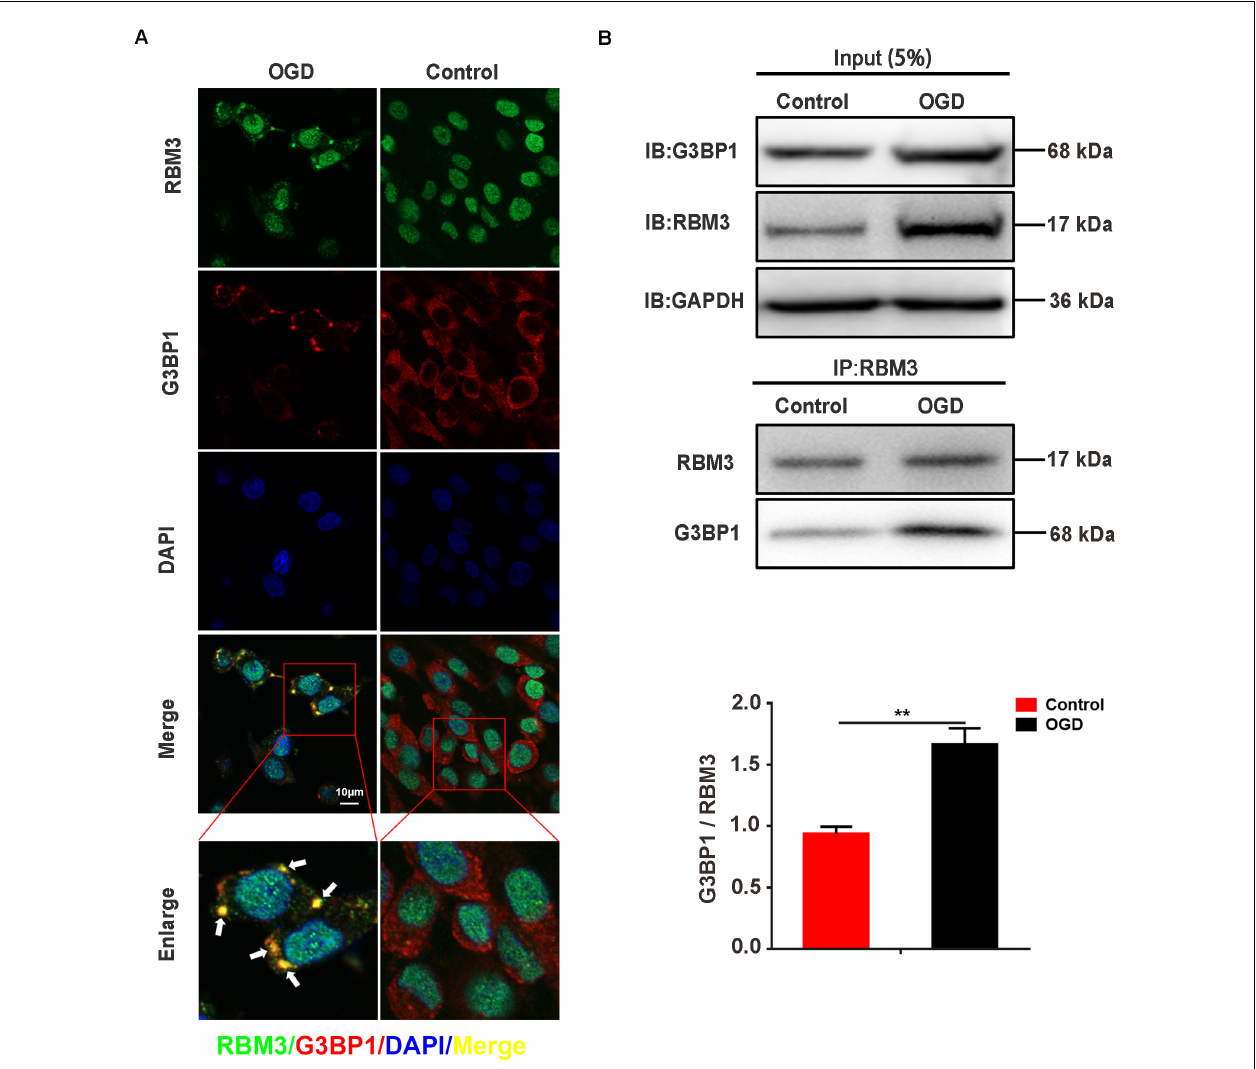
FIGURE 5 | RBM3 interacts with G3BP1 in PC12 cells under OGD stimulation. (A) The colocalization of RBM3 with G3BP1. Representative merged images showing the colocalization of RBM3 with G3BP1 in PC12 cells under 6 h of OGD stimulation (Green represented RBM3; red represented G3BP1; yellow